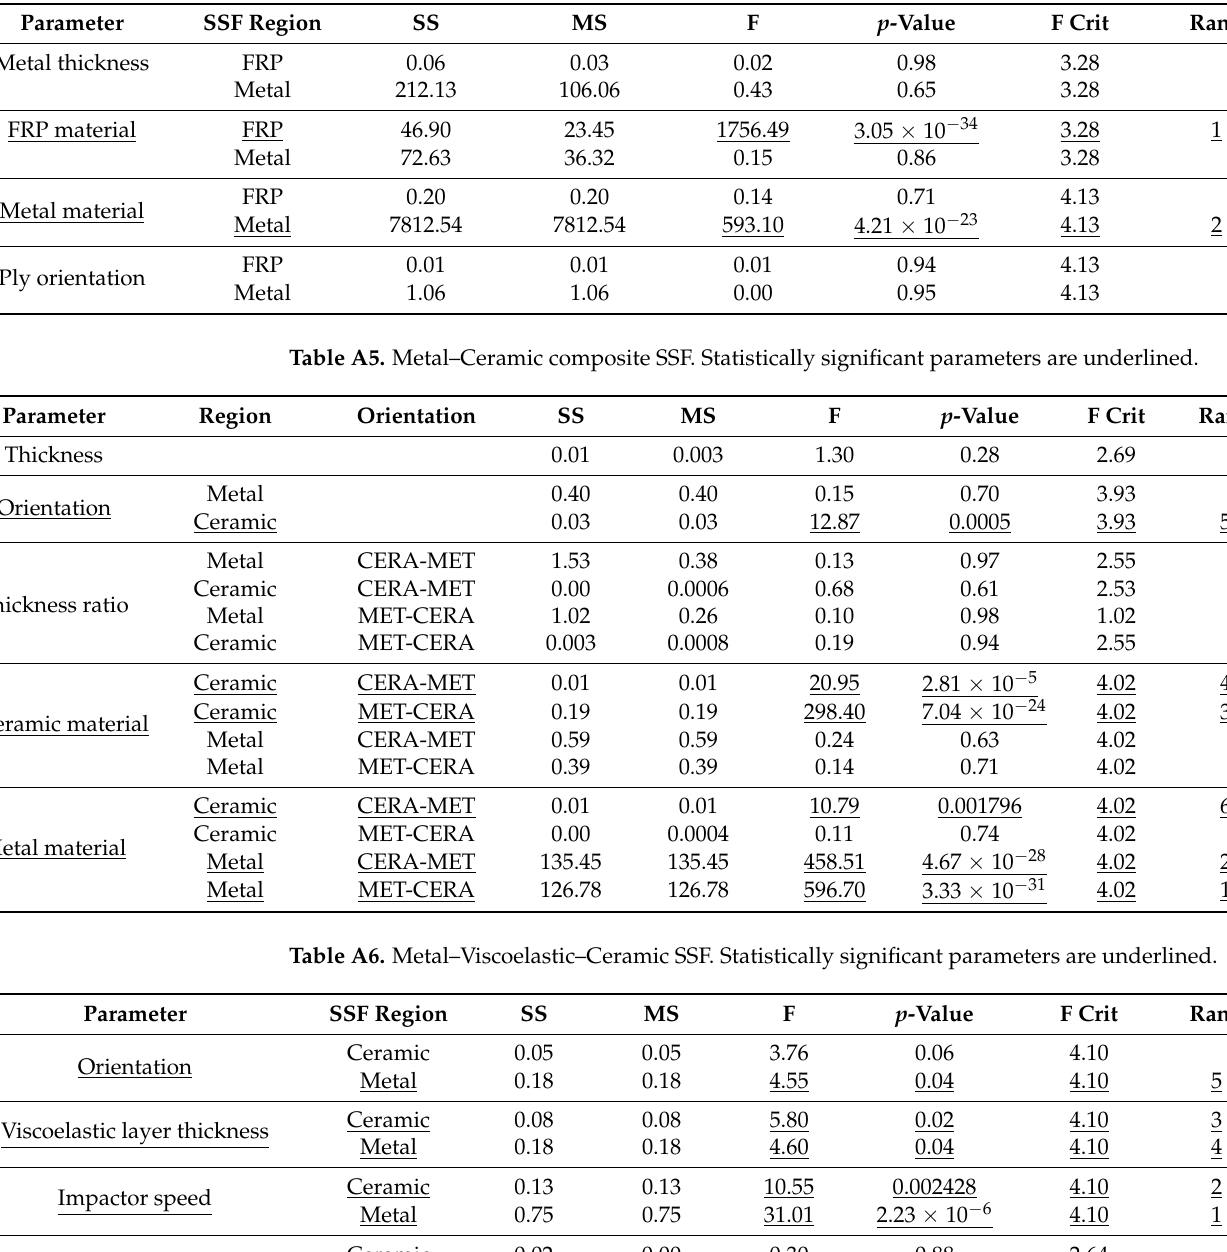
Table A4. Metal–FRP composite SSF. Statistically significant parameters are underlined.